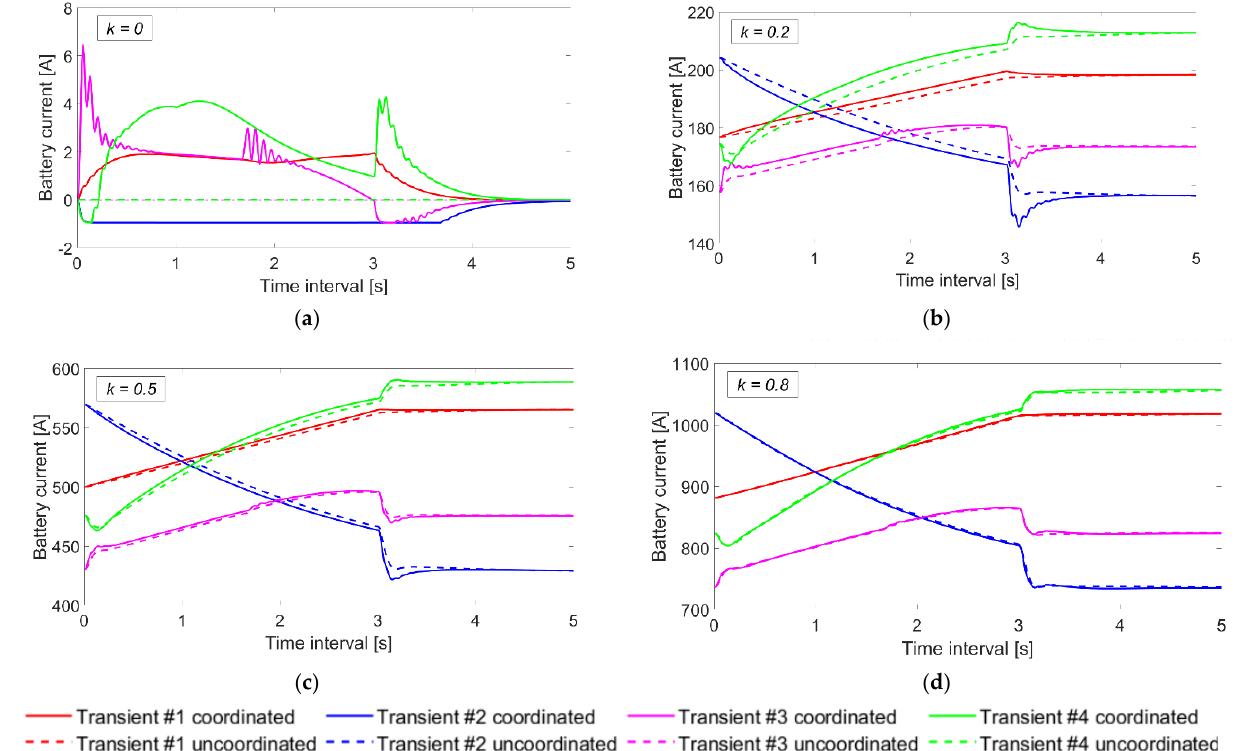
Figure 10. Effect of coordination on battery current with different values of electric contribution: ( a ) k = 0, ( b ) k = 0.2, ( c ) k = 0.5, and ( d ) k = 0.8.